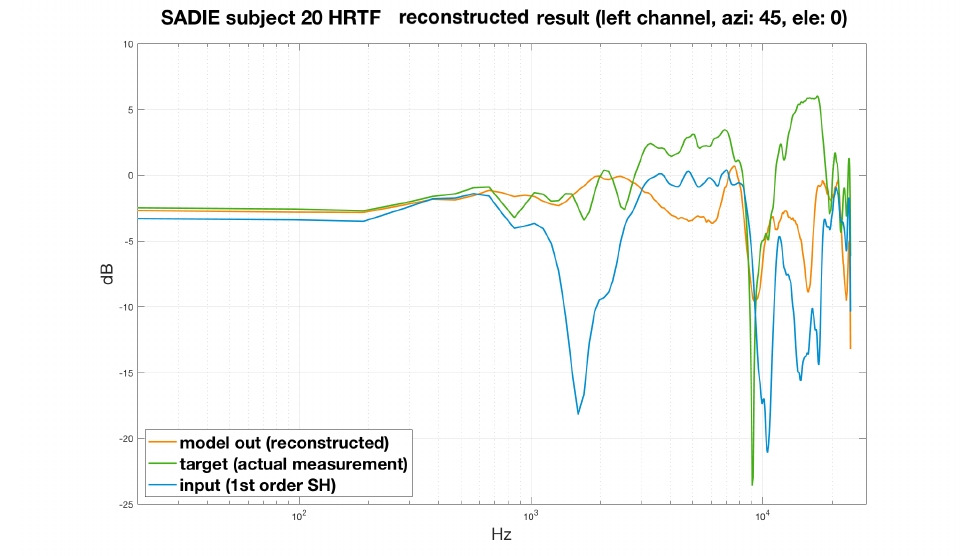
Figure 4. Restoration result example for ipsilateral HRTF response with DAE only (orange: model restored output, green: actual HRTF measurement, blue: SH-interpolated HRTF.)